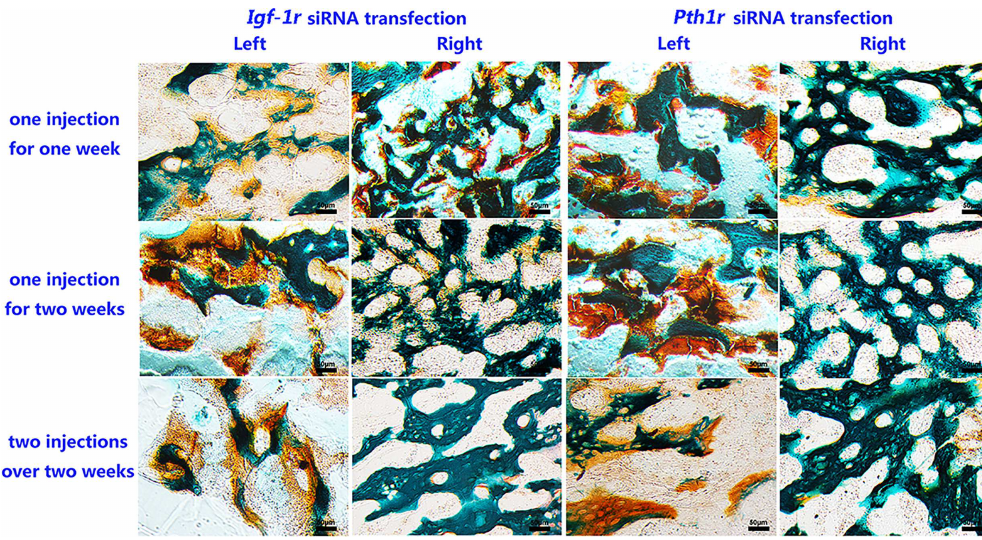
Fig 9. Representative Photomicrographs of Undecalcified Sections Stained with Goldner’s Trichrome. In the left tibias treated with Igf-1r or Pth1r siRNA, osteoidaccountedfor a very large proportion, which was obviously greater than that in the right tibias, in which the majority was mature trabecular bone. Mature trabecularbone and osteoidare stainedgreen and red, respectively. Scale bar = 50 μ